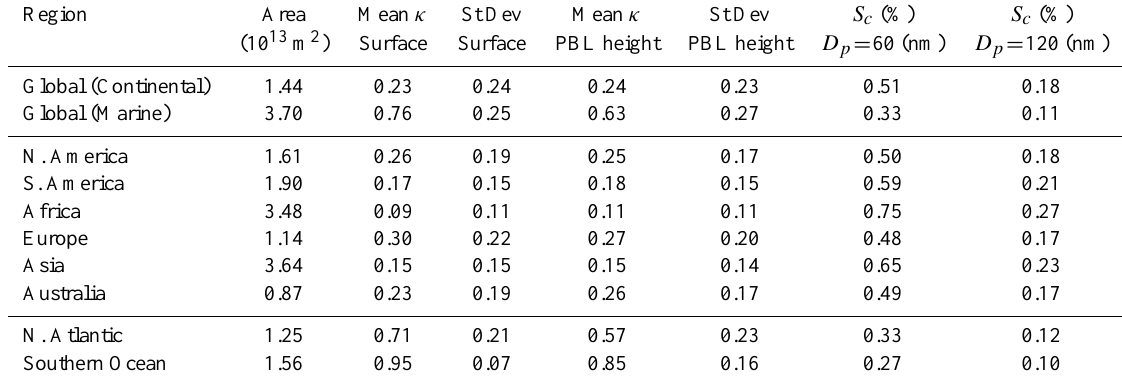
Table 5. Simulated global and regional annual mean κ values (and standard deviation) at the surface and at the simulated PBL height under pre-industrial conditions. Standard deviation is calculated for the year from 5-hourly average data. S c is the critical supersaturation (%), calculated using the regional mean κ at PBL height. Area column gives total land area for land sites, and marine area for marine sites. Region Area Mean κ St Dev Mean κ St Dev S c